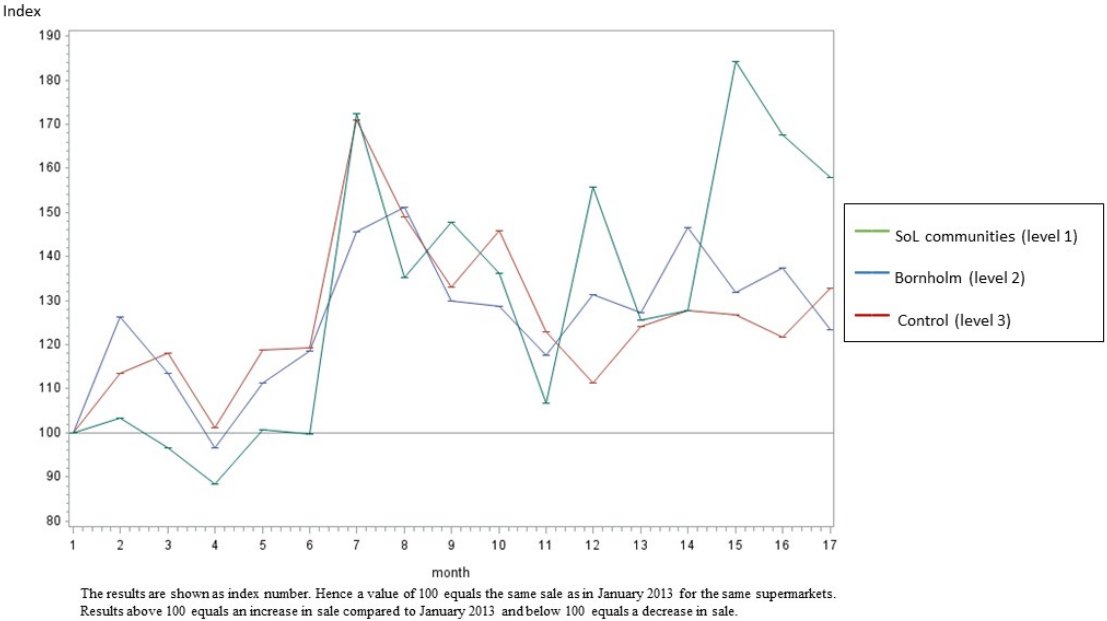
Figure 3. The development in monthly sales of canned fish from January 2013 to June 2014 in the SoL intervention communities, the Island of Bornholm and the control area (Odsherred). Data are shown as index numbers.